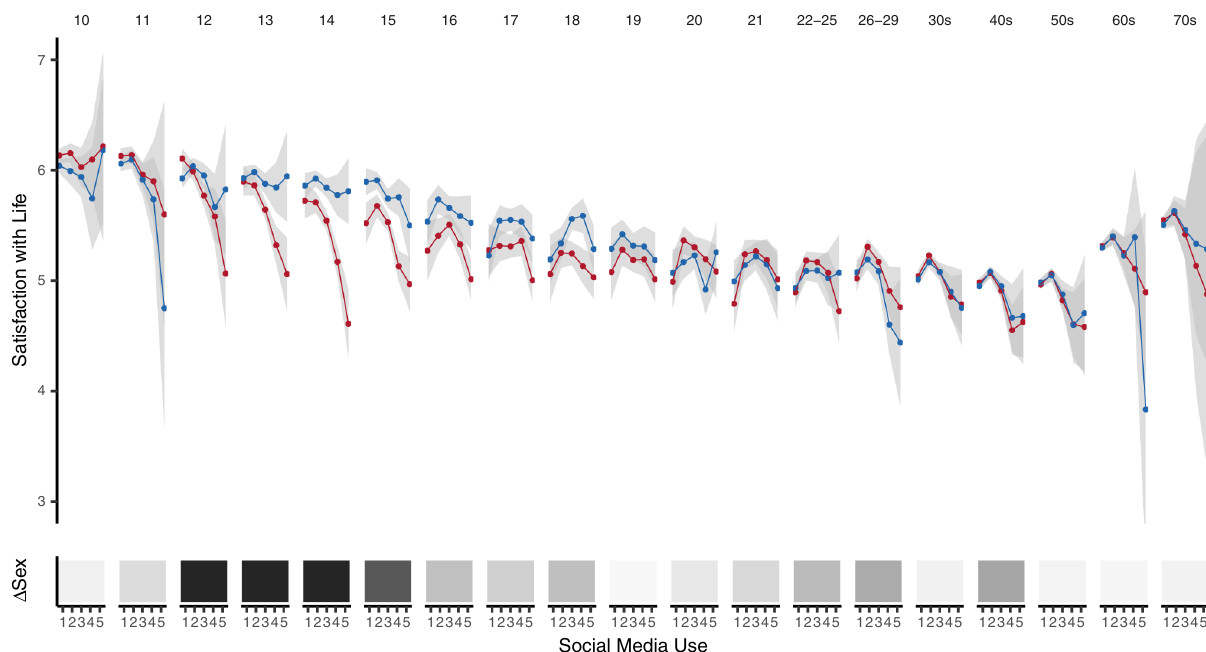
Fig. 1 Estimated social media use and life satisfaction ratings across the lifespan. Top: The cross-sectional relationship between estimated social media use and a one-item life satisfaction measure for 72,287 UK participants between the age of 10 and 80 years. The results are split by age and self-report sex: females = red, males = blue. The 95% con fi dence intervals represent the lower and upper Gaussian con fi dence limits around the mean based on the t-distribution. Bottom: Shading of each rectangle represents calculated AIC weights, i.e., whether a model relating estimated social media use and ratings of life satisfaction that takes into account a possible sex difference is more likely to represent the data than a model that does not take into account sex: darker shade = model with sex differences is more likely. It should be noted that as high levels of social media use are very rare in the youngest and oldest age groups present in the data (e.g., ages 10, 11, and 60 + , Supplementary Fig. 1), one cannot evaluate functional form in these groups. Further, as most participants were measured multiple times, more than one data point per participant will appear in this graph. Source data for this fi gure are provided as a Source Data fi